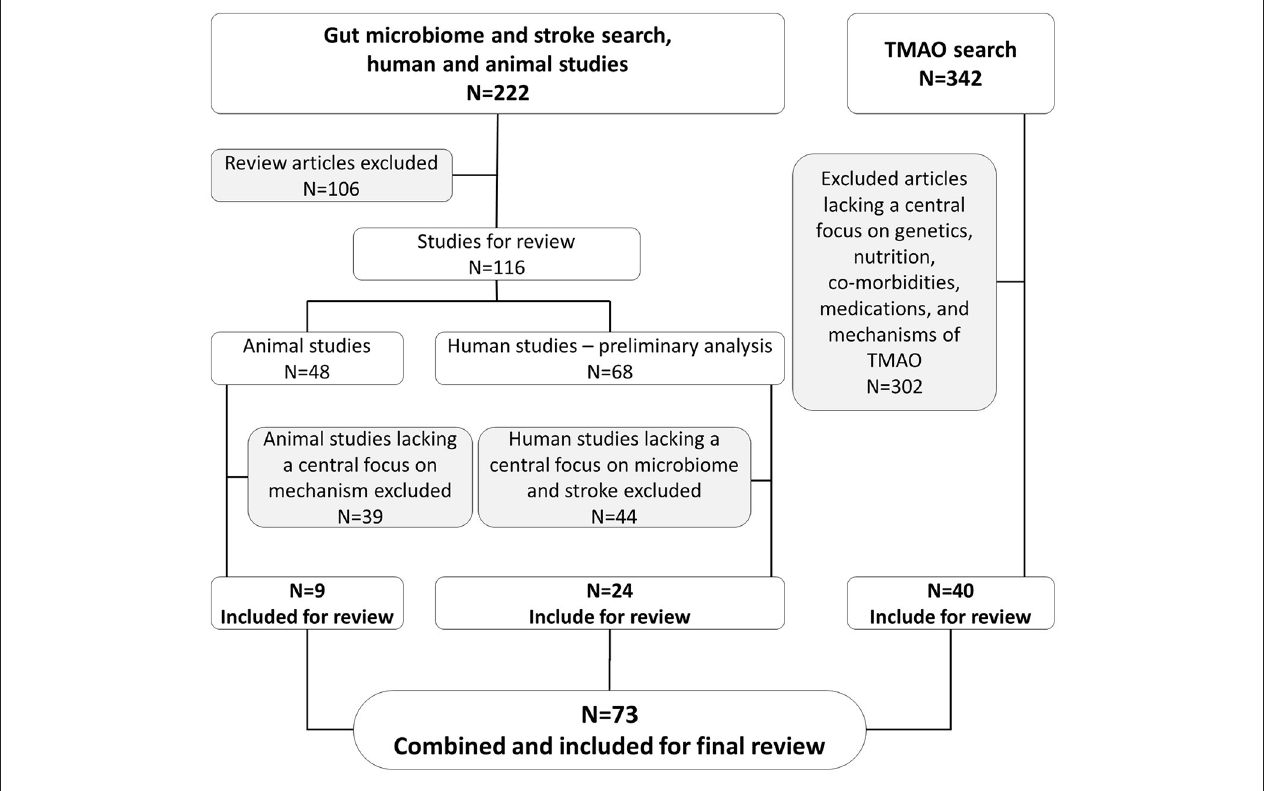
FIGURE 1 | Schematic representation of inclusion and exclusion of articles in present study.